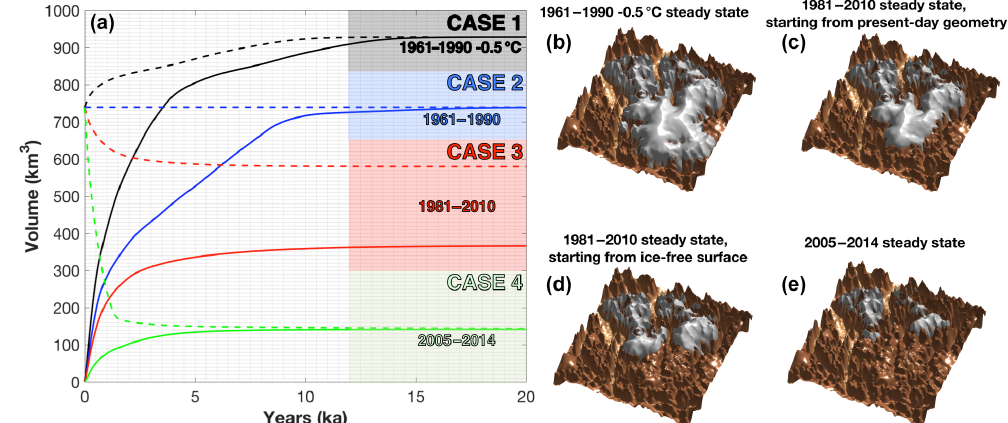
Figure 9. (a) Volume build-up of Hans Tausen Iskappe for different initial states (ice-free surface and 1961–1990 steady-state geometry) and under different climatic conditions. The four coloured regions (cases) represent clusters of simulations with a similar build-up and thresholds in the system and are defined and discussed in the text. (b, c, d, e) Modelled steady-state geometry for different climatic forcings.